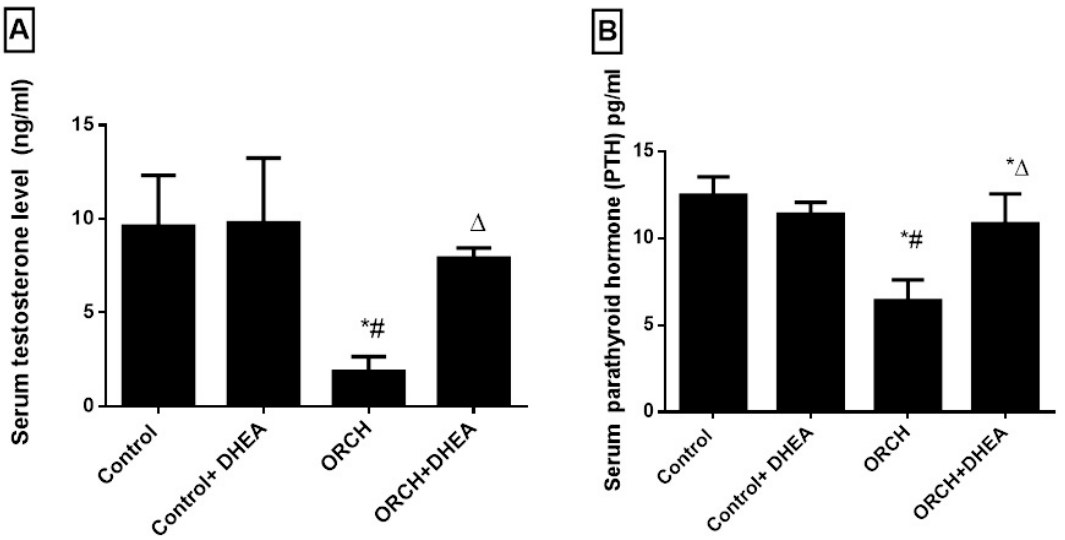
Figure 1. Effect of orchidectomy and DHEA (dehydroepiandrosterone) treatment on the serum levels of ( A ) testosterone and ( B ) parathyroid hormone levels. Data were expressed as mean ± SD of 8 rats. *: p < 0.05 versus control, #: p < 0.05 versus control + DHEA, ∆ : p < 0.05 versus ORCH (orchidectomized rats).